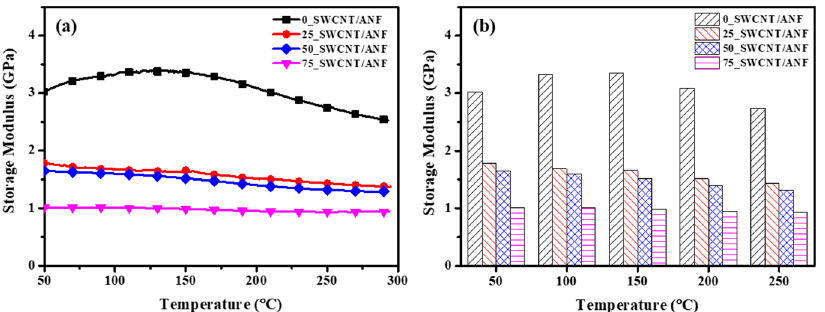
Figure 7. Storage moduli from DMA measurement depending on the temperature. ( a ) Results of storage modulus according to SWCNT content, ( b ) comparison at specific temperatures.